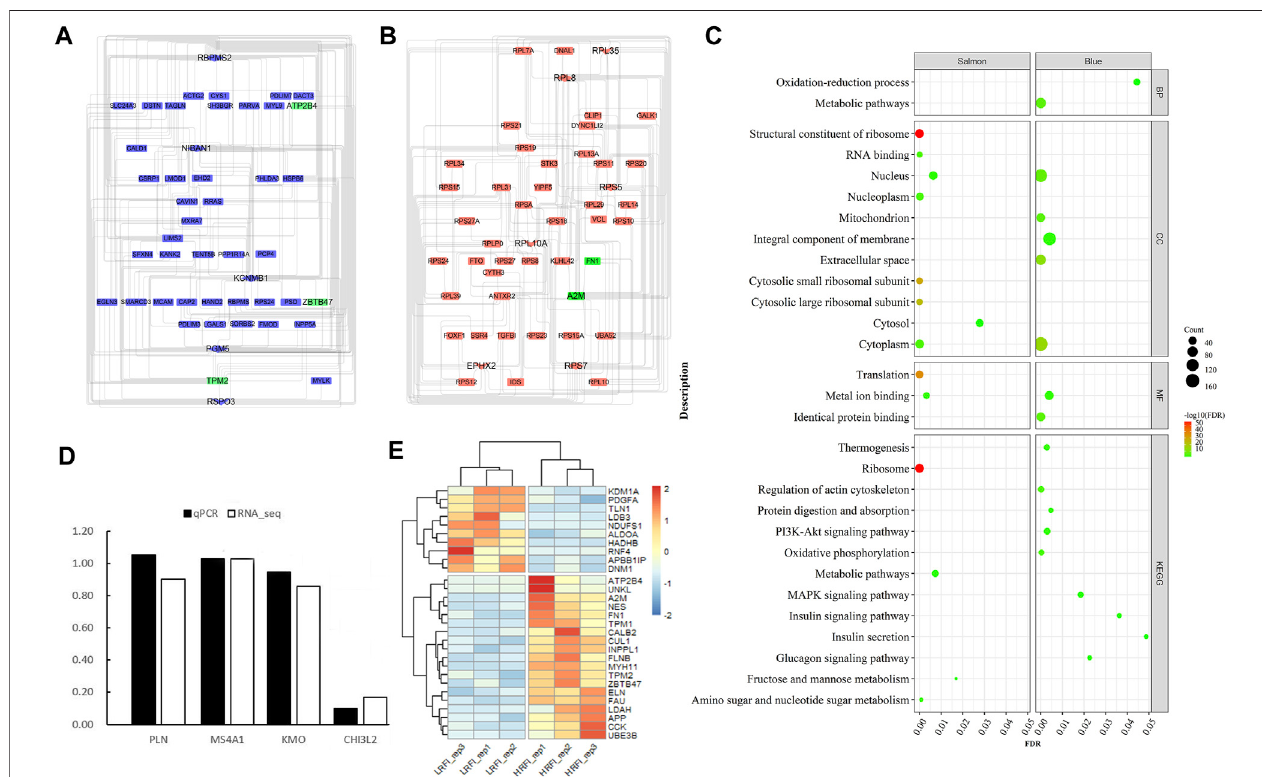
FIGURE 6 | PPI and enrichment analysis of DEGs in the salmon and blue modules (considering the number of interaction networks, the top 200 genes in the weighted interaction networkwere selected to construct the interaction network). (A) Interaction relationship in the blue module, consisting of47 nodes and 200edges. (B) Interactionrelationshipinthesalmonmodule,composedof48nodesand197edges.Intheblueandsalmonmodules,thetop40geneswerede fi nedashubgenes. The shape “ Ellipse ” represented the top 20 genes, and the shape “ hexagon ” denoted the genes ranking 21 – 40. (C) represent the enrichment analysis of genes in the blue and salmon modules. In (C) , the color and size of the dot represent the number of enriched genes and the magnitude of signi fi cance, respectively. (D) qPCR results for four randomly selected genes. (E) Heatmap of all candidate genes identi fi ed. Blue to yellow fading means gene expression increases, positive and negative numbers do not indicate positive or negative expression but up-or